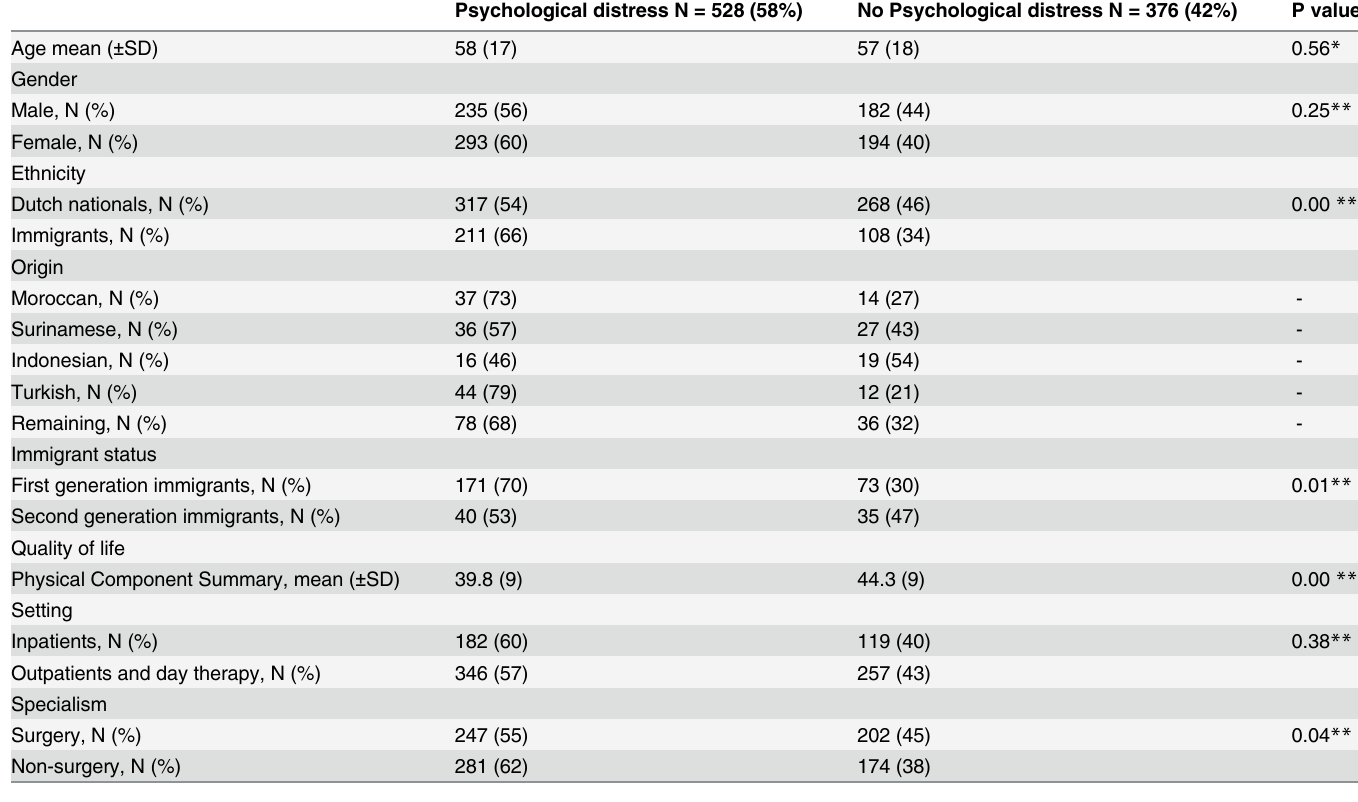
Table 2. Association of presence of absence of psychological distress with age, gender, ethnicity, immigrant status, quality of life, setting and